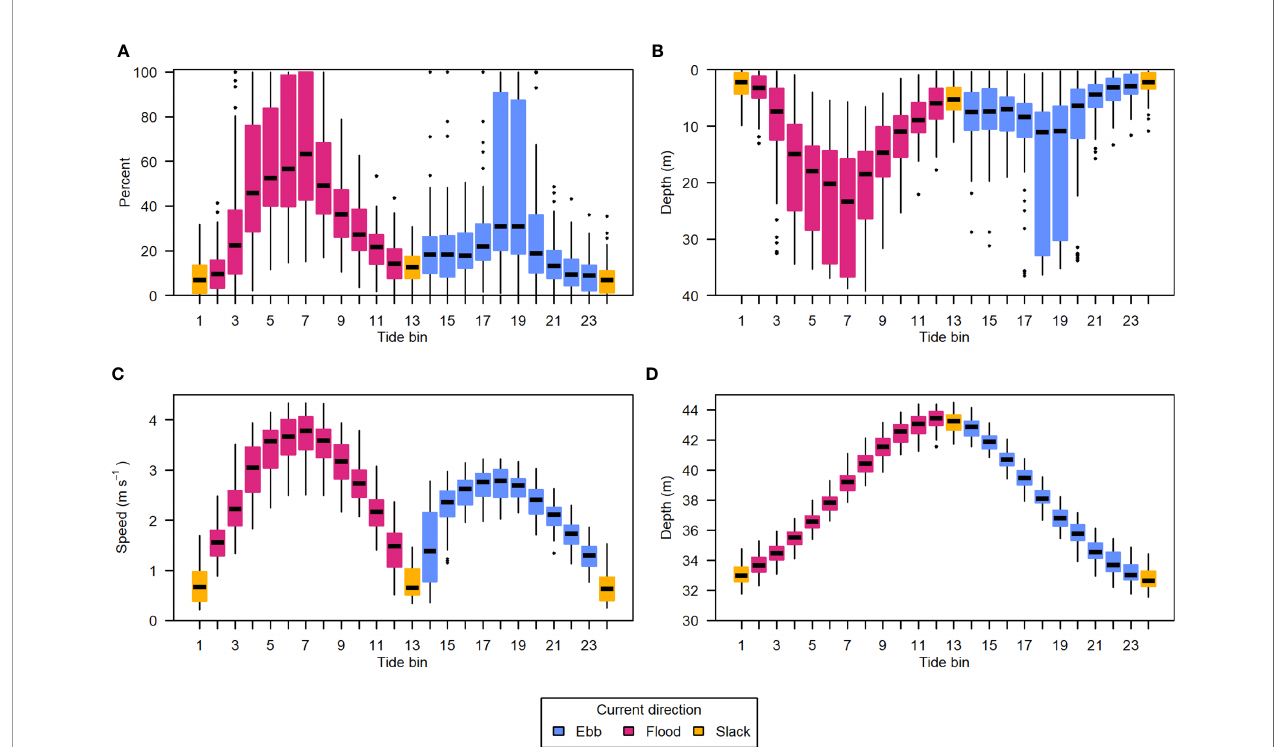
FIGURE 9 | Data from all recording periods summarized by position in the tidal cycle. (A) Percent of analyzable samples missing due to entrained air contamination, (B) depth of entrained air layer relative to the surface, (C) water column mean current speed, and (D) water column total depth. The tidal cycle was divided into 24 equal bins, each spanning approximately half an hour. Light blue indicates ebb tide, dark pink indicates fl ood tide, and yellow indicates the tide bins containing slack tides. Horizontal black lines are the median of each group, boxes span the interquartile range (IQR), whiskers extend to 1.5*IQR, and points are outlying